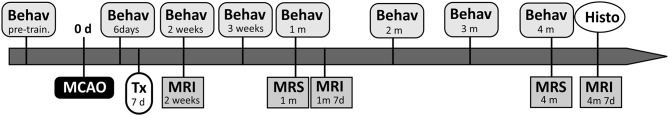
Schematic timeline of the experiments. The day when MCAO have been performed was taken as day 0. Animals were transplanted (Tx) with iPSC-NPs 7 days after lesion and were followed by magnetic resonance imaging (MRI), magnetic resonance spectroscopy (MRS), behavioral tests (Behav) over 4 months. Histological data (Histo) were acquired in the end of the experiment. D, days; m, months.